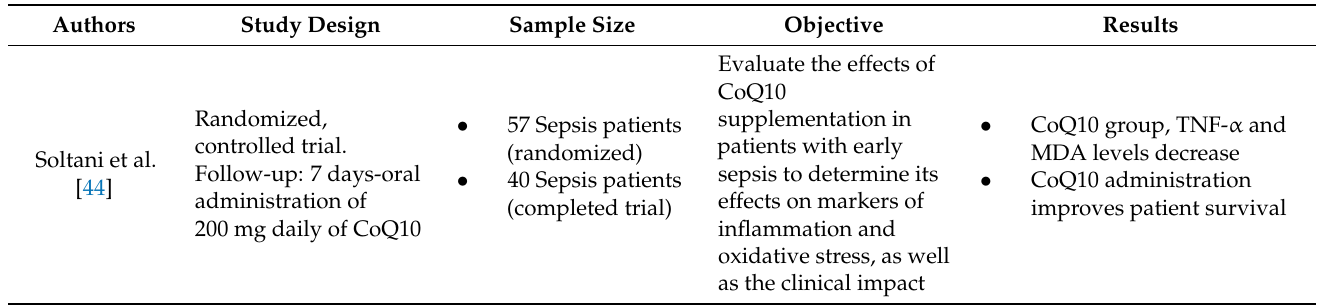
Table 1. Antioxidants and anti-inflammatory effects of CoQ10 in infectious diseases: human clinical